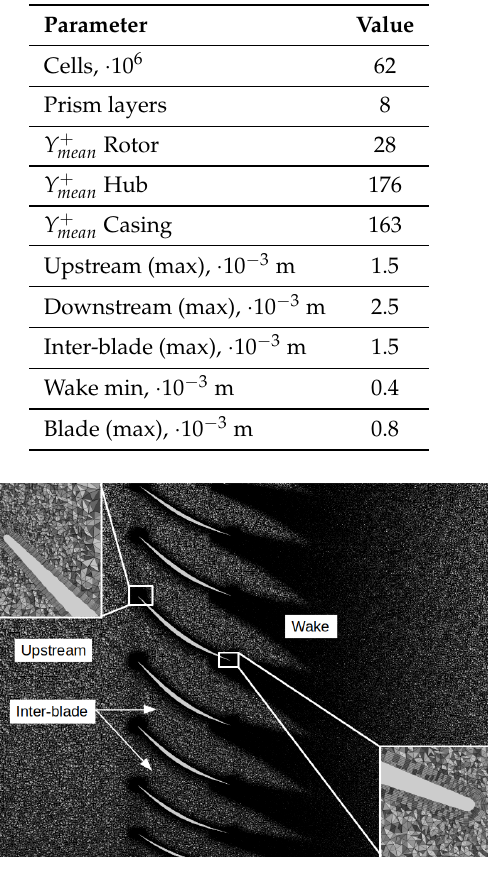
Figure 2. Slice of the computational